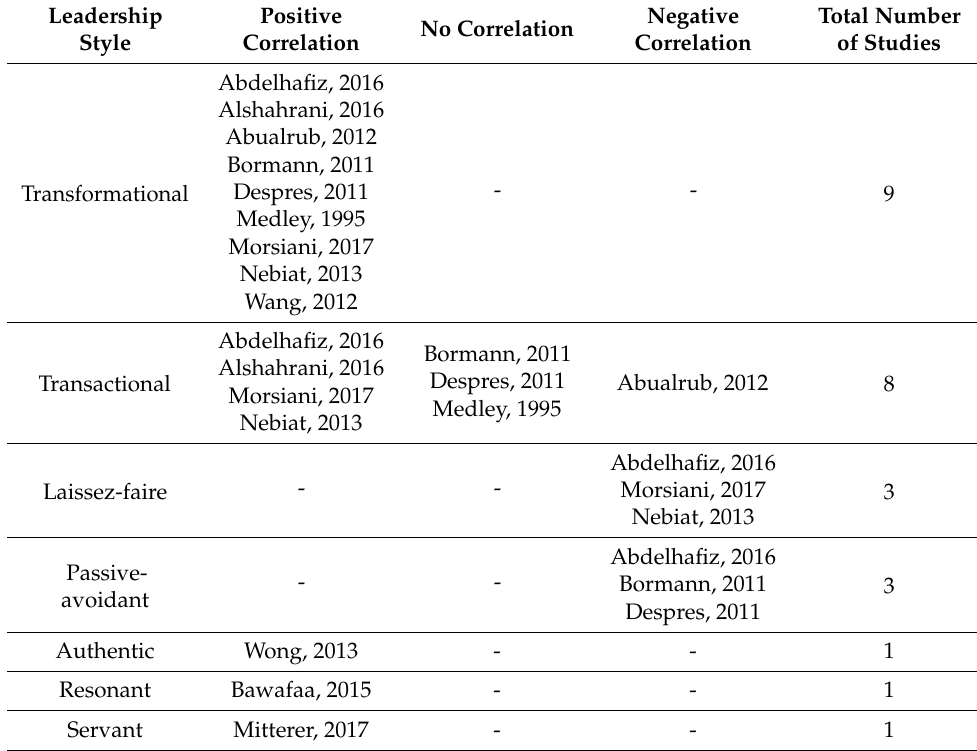
Table 1. Correlation between leadership styles and job